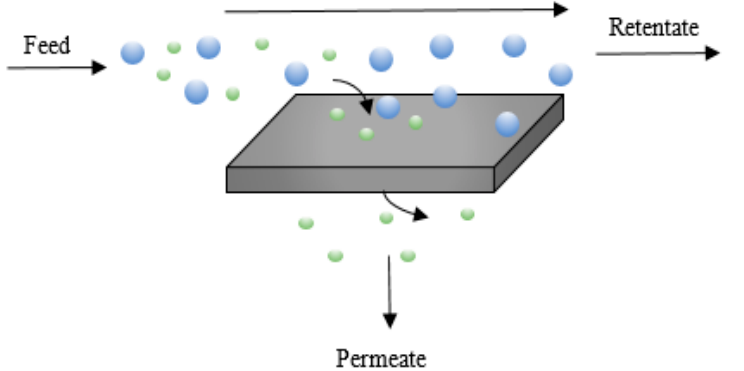
Figure 1. Simplified schematic of membrane separation.